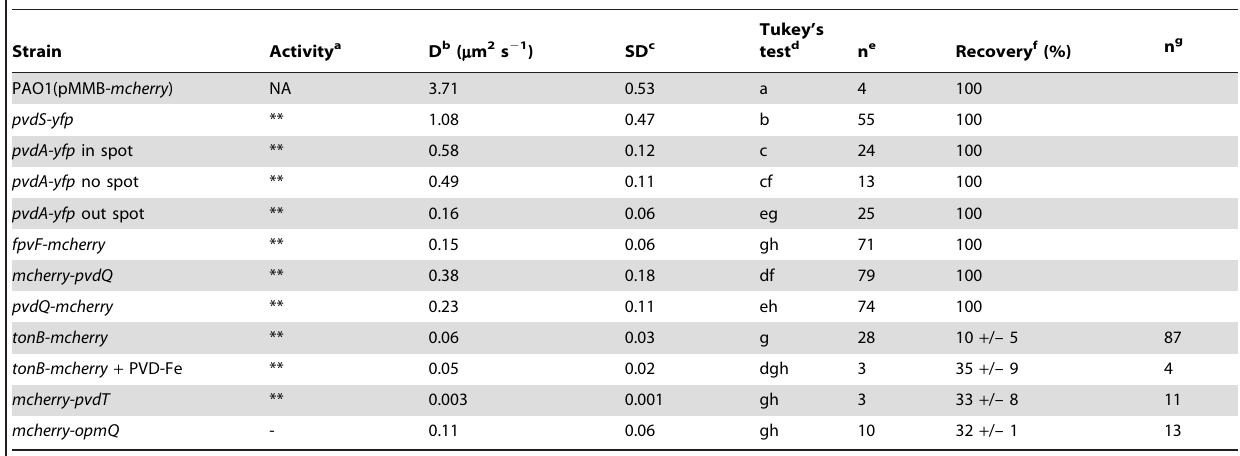
Table 2. Summary of FRAP experiment analysis.